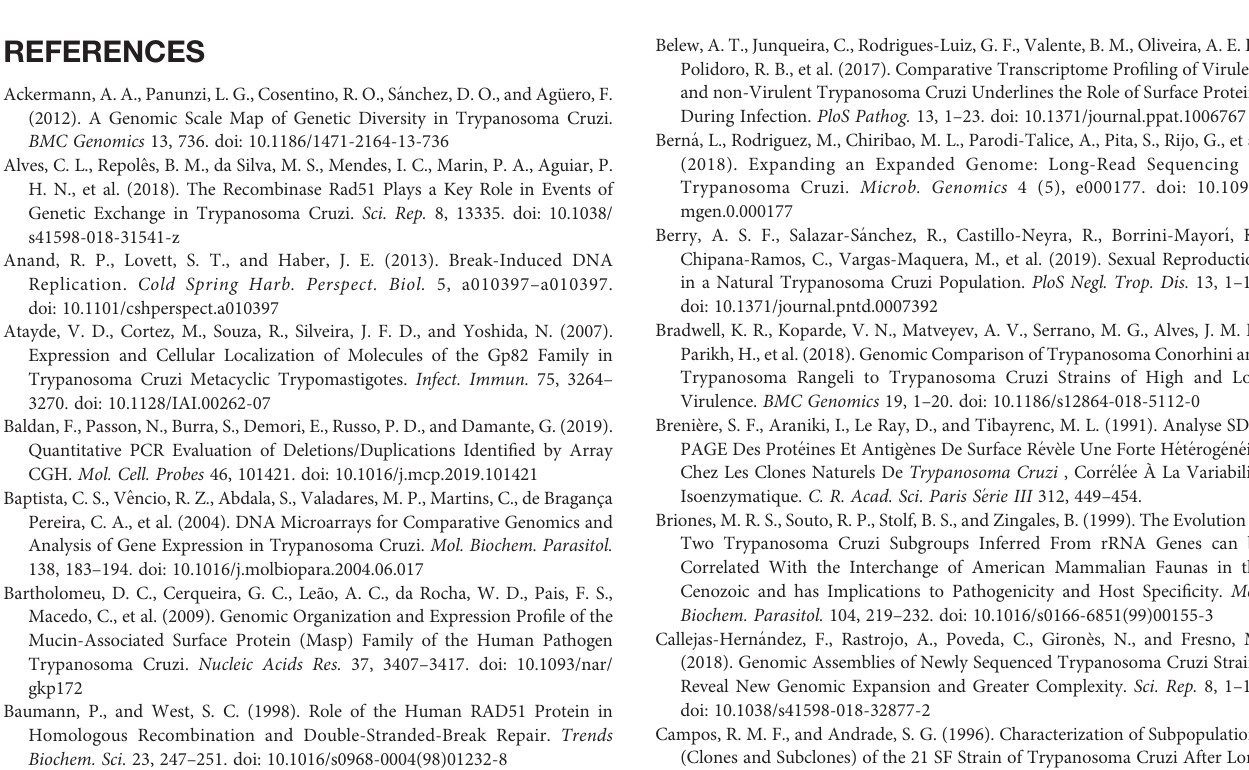
strain. Hansenula wingei (HW) chromosomes were used as PFGE DNA size markers. The lengths of HW chromosome bands are indicated in megabases (Mb) to the left of the gel. The boxed regions of each gel were used in the Southern blot hybridization. Botton Panel. The chromosomal bands were transferred onto nylon membranes and hybridized to the indicated chromosome markers. The identi fi cation (number or letter) and size (Mb) of hybridizing chromosomal bands are indicated in the fi gure. In silico chromosomes and markers are: (A) TcChr8, TcCLB.510337.30 – adenylosuccinate lyase; TcCLB.506649.50 - cytochrome c oxidase assembly factor; (B) TcChr12, TcCLB.509573.40 - hypothetical protein ; TcCLB.503595.10 - hypothetical protein; (C) TcChr6; TcCLB.507603.180 - ubiquitin hydrolase 6; (D) TcChr22; TcCLB.509499.20 - beta propeller protein 1 BPI; TcCLB.504427.89 - SET domain containing protein; TcCLB.509767.180 - exosome componente CSL4. Supplementary Figure 9 | A model of unequal crossing over accounting for the rearrangement in D11chromosomehomologous to TcChr6. (A) First itisshownthe pair of parental homologous chromosomes, next the duplicated parental sister chromatids. The repeated sequences (pseudogenes of RHS, TS and DGF-1) (in yellow) fl anking the regions involved in the deletion (green) recombination events are indicated. After mitotic DNA replication, the homologous chromatids are paired with slipping of repeated sequences prior to recombination. Unequal homologous chromatid cross-over resulting in two DNA molecules of different sizes. (B) At the end of mitotic division two sets of homologous chromosomes are separated from each other in the daughter cells. Each daughter cell received a homologous recombinant chromatid. Clone D11 received the smaller recombinant chromatid generated by deletion of a large segment (in green). S, Esmeraldo haplotype; P, non-Esmeraldo haplotype. Supplementary Figure 10 | Real-time PCR estimation of gene copy number of markers in G strain and clone D11 for aCGH validation. Genes located in different chromosomes were ampli fi ed from the genomic DNA of the strain G and clone D11 and detected by SYBR Green. The graphs represent mean ± SD of three independent experiments performed in triplicate. Comparison between G and D11 strain was determined using Unpaired Student t test. P values were shown in the fi